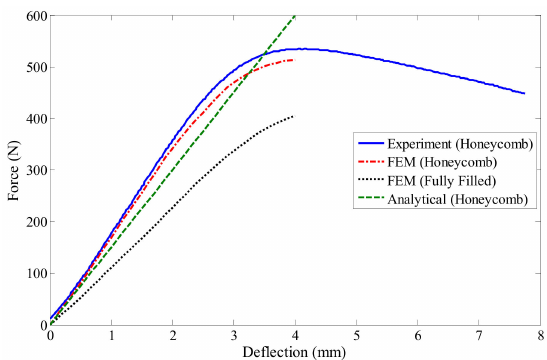
Figure 13. Comparison of the experimental, numerical, and analytical load–deflection curves for the three-point bending test of the honeycomb and fully-filled